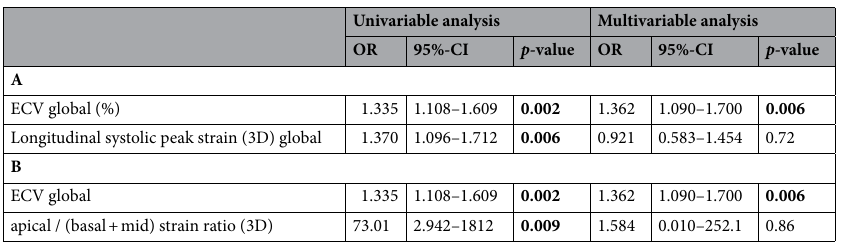
Table 4. Univariable and multivariable logistical regression analysis regarding the prediction of cardiac amyloidosis. Bold values indicate significant p -value <